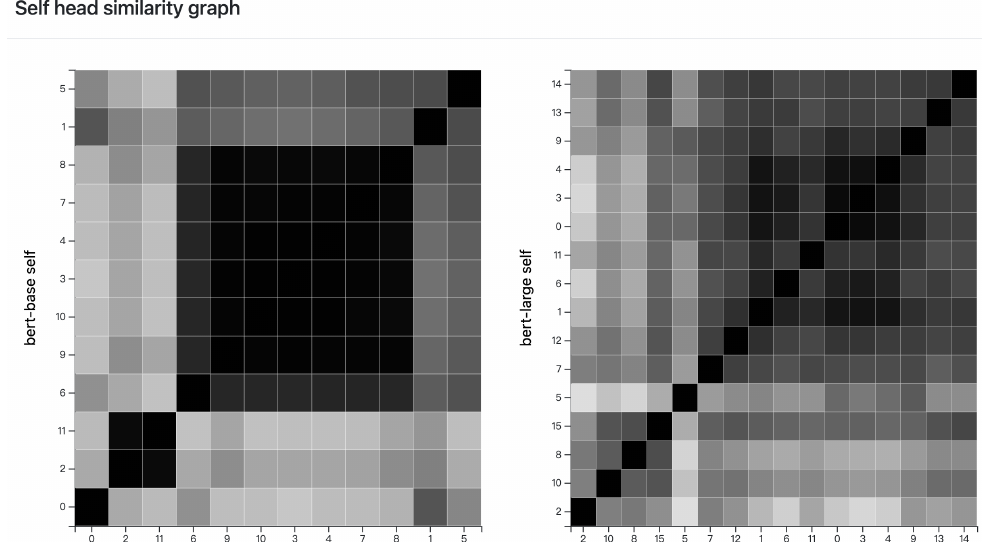
Figure 8. Self head similarity graph. The graph assists users to compare the similarity of all heads of a single layer in a model. The information from this graph can clearly indicate whether the behavior of these heads is similar.